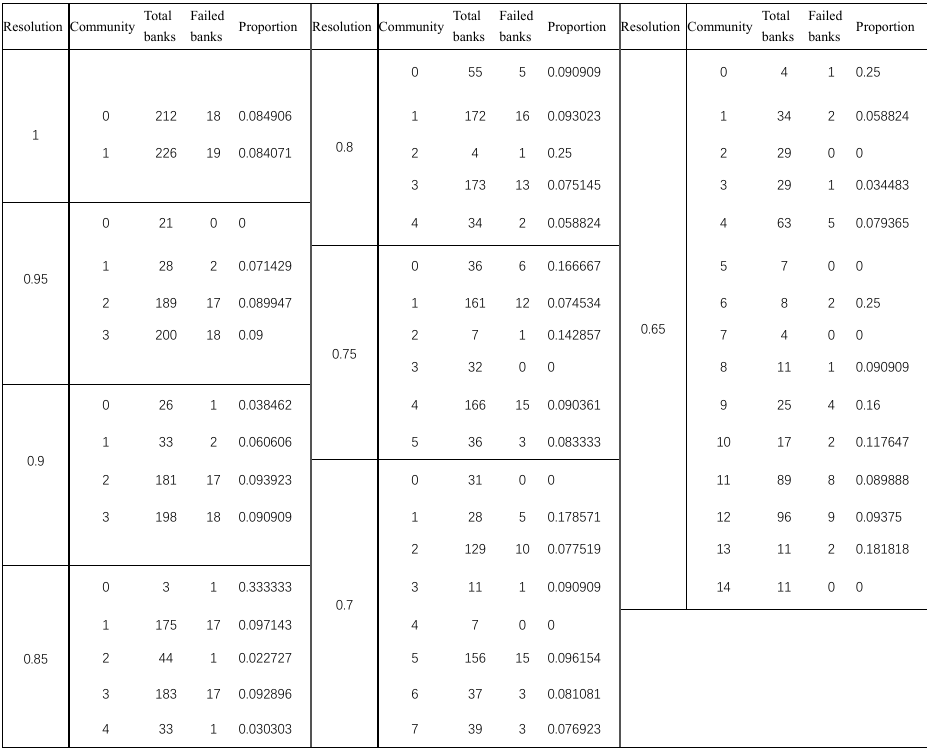
Figure 7. The results of the community division of the IL network with a different